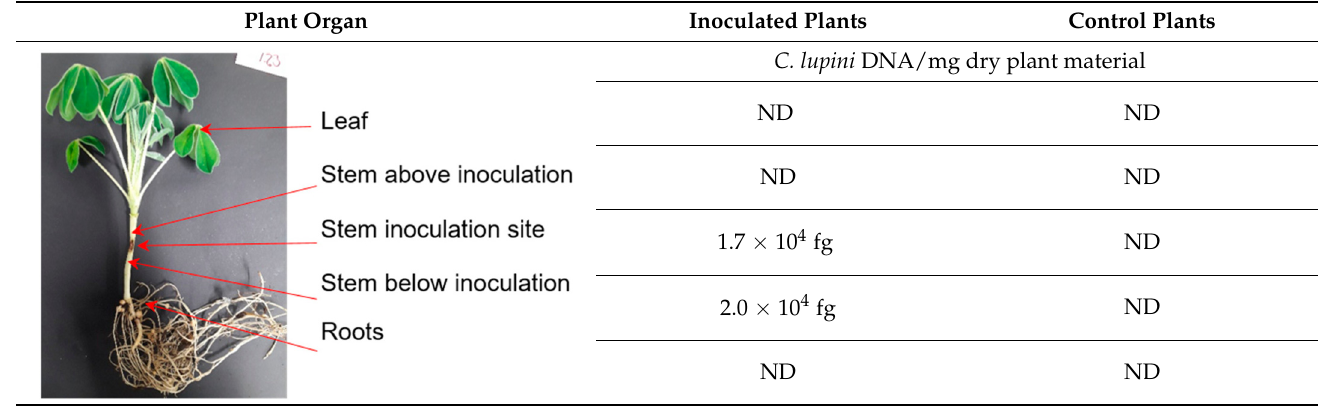
Table 2. Quantification of C. lupini DNA in different plant organs of artificially inoculated plants 15 days